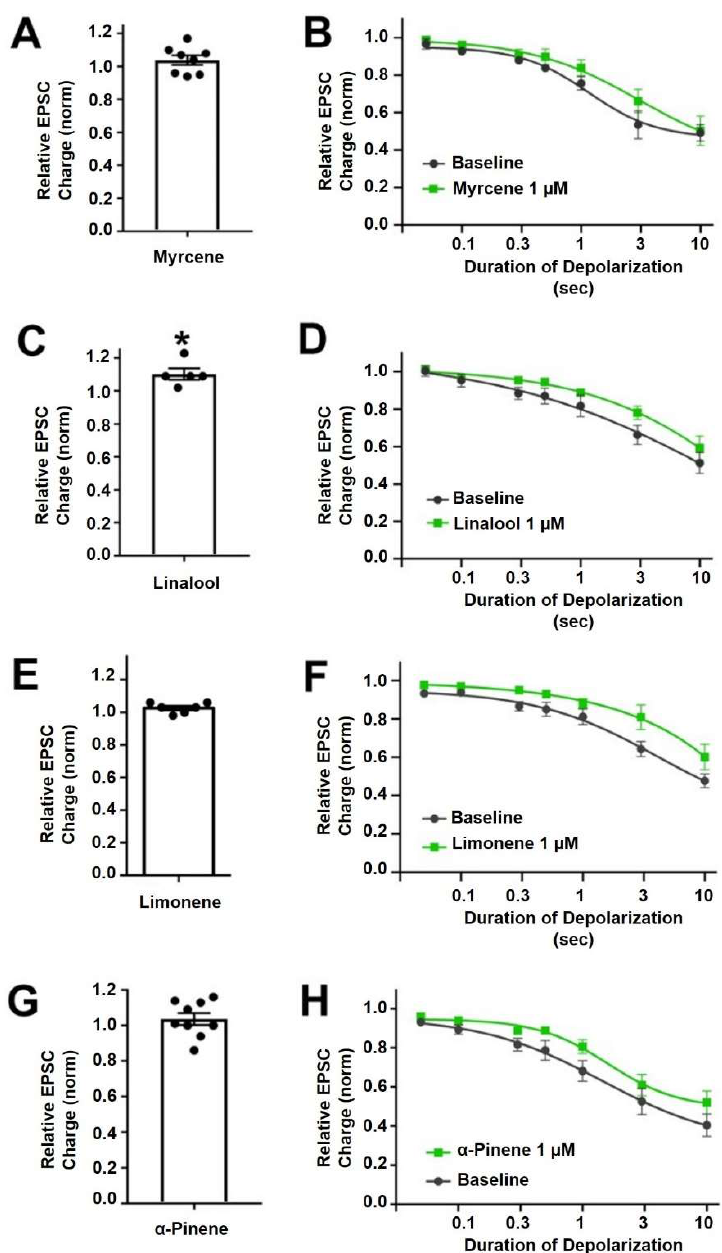
Figure 2. Myrcene, linalool, limonene and α -pinene do not alter cannabinoid signaling in autap- tic hippocampal neurons. ( A ) Myrcene (1 µ M) did not alter EPSCs. ( B ) Myrcene also did not have an effect on DSE responses. ( C ) Linalool (1 µ M) slightly increased EPSCs. ( D ) However, linalool had no effect on DSE responses. ( E ) Limonene (1 µ M) did not alter EPSC sizes ( F ) and did not significantly inhibit DSE responses. ( G ) α -pinene (1 µ M) did not alter EPSCs. ( H ) Similarly α -pinene did not inhibit DSE responses. * p < 0.05 one-sample t -test vs. 1.0 or vs. baseline at 3 s of depolarization. Mean ± SEM shown. 2.2. Nerolidol Inhibits Cannabinoid Signaling by Altering Endocannabinoid Production Nerolidol is a sesquiterpene (Figure 1) that is described as having sedative prop- erties [28]. It proved to have the most interesting profile of the terpenoids tested here. Nerolidol did not directly alter neurotransmission when applied (Figure 3A, EPSC charge relative to baseline (1.0 = no inhibition) after nerolidol (1 µ M): 0.983 ± 0.016, n = 15; p = 0.319 by one-sample t -test vs. 1.0), but did have an inhibitory effect on DSE